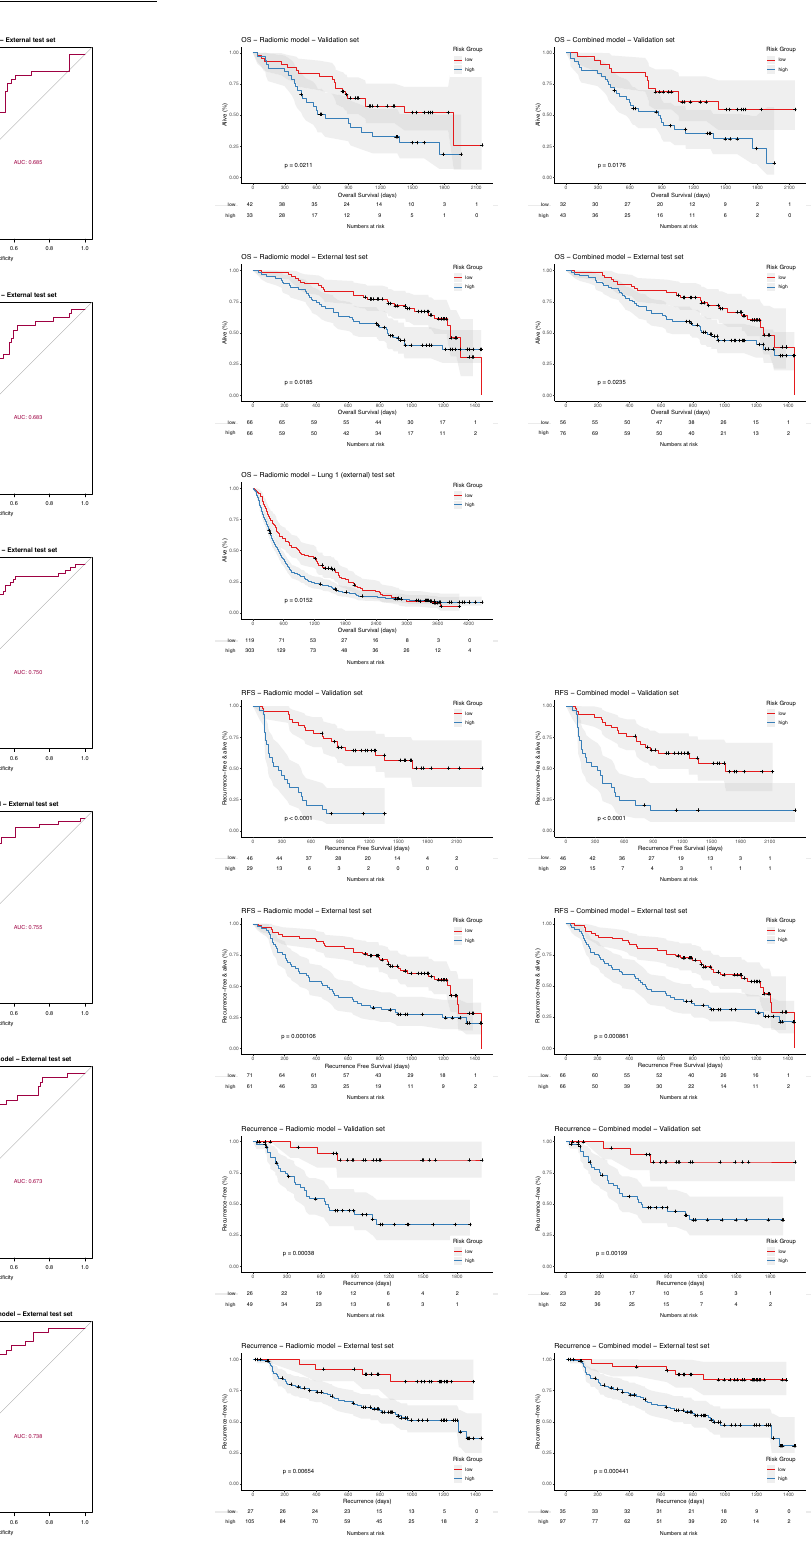
Fig. 5 Kaplan Meier survival curves for low and high-risk groups in both validation and external test set(s) for the Radiomic and Combined models for OS, RFS and recurrence. P -values correspond to log-rank tests. Curves demonstrate good separation between high and low risk groups with log-rank tests con fi rming a statistically signi fi cant difference for prediction of each endpoint at the 5%